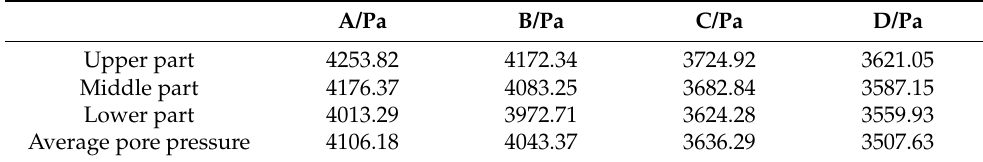
Table 3. Pore pressure of ore samples at different depths after